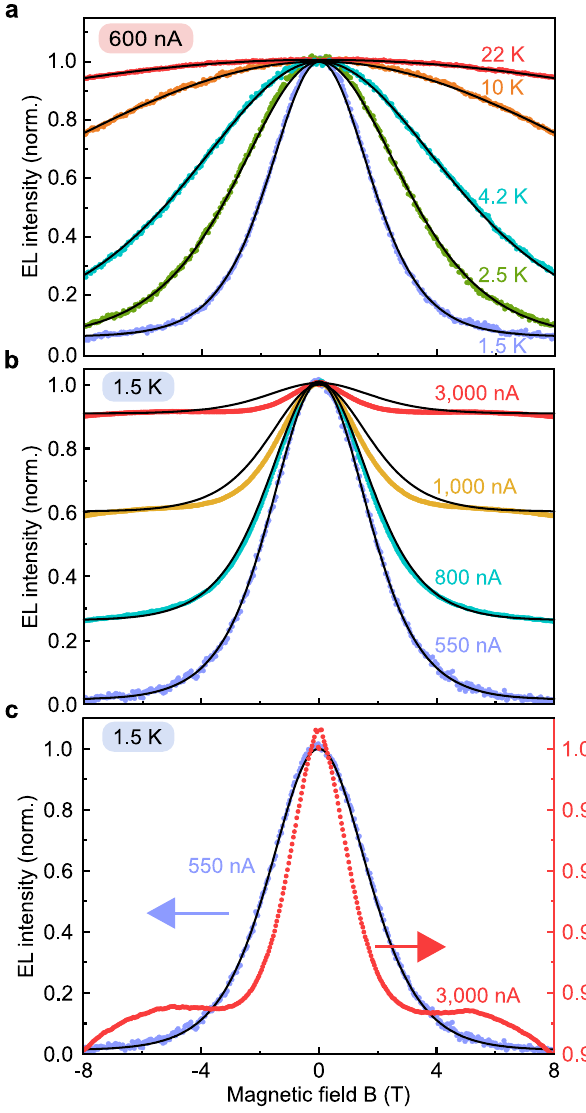
Fig. 2 Current and temperature dependence of TSP-induced MEL of a SYPPV OLED. a Temperature dependence at a device current of 600 nA. At elevated temperatures, the functionality of the MEL curves is in good agreement with the Boltzmann-type activation expected of TSP. b Current dependence at a temperature of 1.5 K. At higher currents, the functionality narrows with respect to the Boltzmann activation behavior [black lines, following Eq. (3)], most likely because long-lived triplet excitons are quenched by free polarons to form additional singlets. c Direct comparison of MEL curves at 550 nA and 3000 nA drive current. Note the different scales for the blue and red